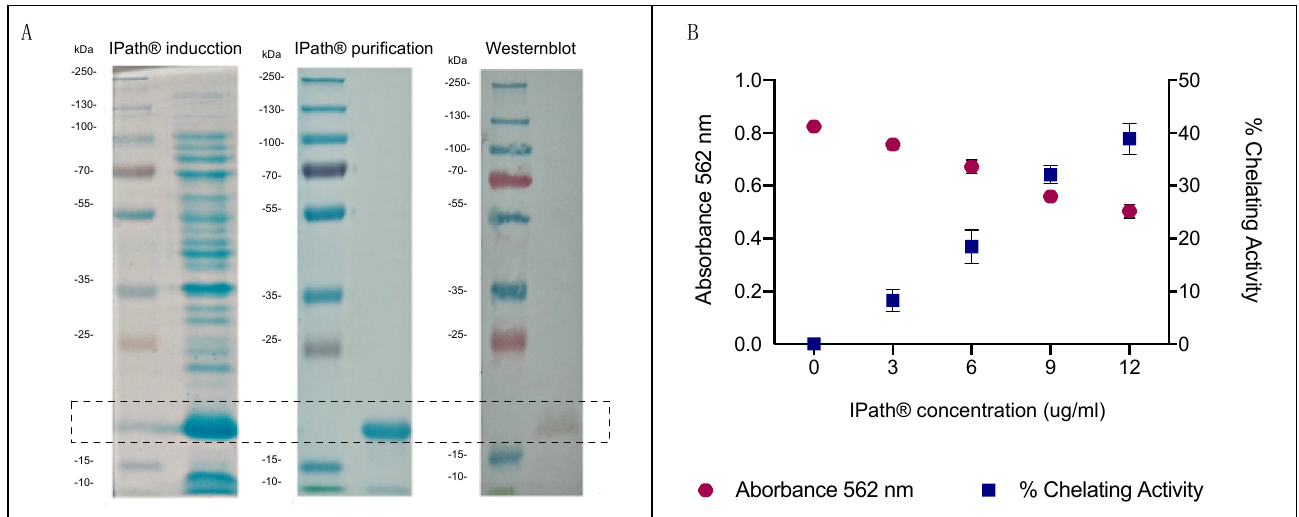
Figure 1. Purification and chelating activity of recombinant IPath ® protein. ( A ) SDS-PAGE (12%) analysis of protein extraction products; SDS-PAGE (12%) analysis of purified IPath ® by size exclusion chromatography; Western blot analysis of purified IPath ® with an anti-His antibody. ( B ) Iron chelating activity of purified recombinant IPath ® .